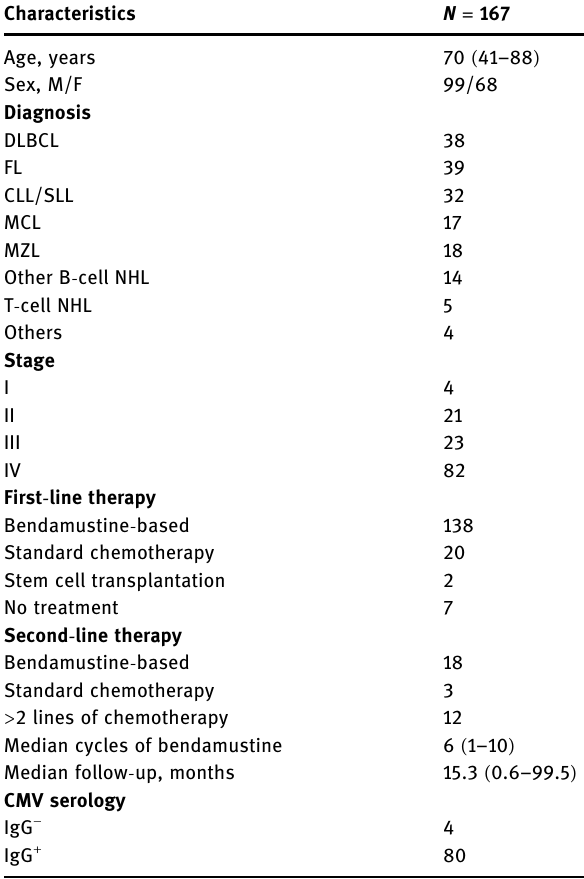
Table 1: Baseline patients ’ characteristics